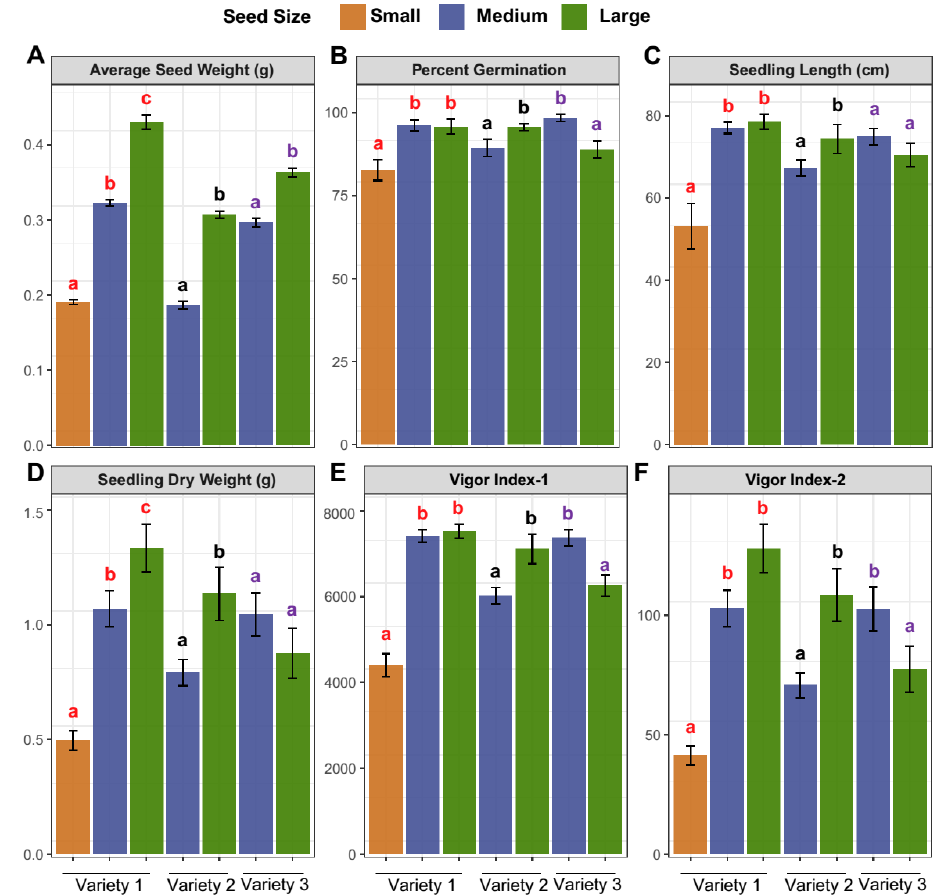
Figure 2. Biometric analysis of different seed size categories (small, medium, large) of the three hybrid corn varieties. Average seed weight (g) ( A ), percent germination ( B ), seedling length ( C ), seedling dry weight ( D ), vigor index-1 ( E ), vigor index-2 ( F ). The means of different seed size categories are compared with in the variety. Means followed by the same letter in each category do not statistically differ from one other according to DMRT at 5% ( p < 0.05) probability level.